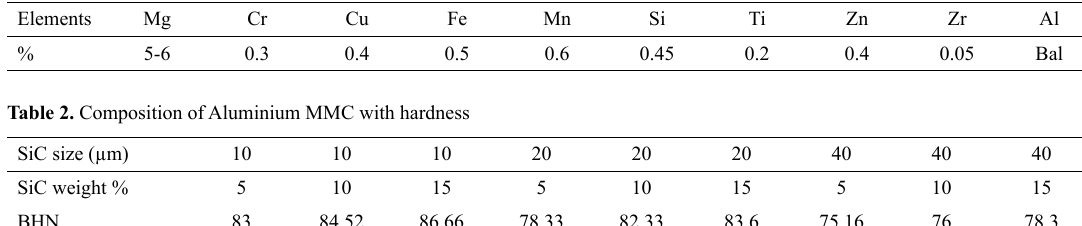
Table 1. Chemical composition of Aluminium 5059